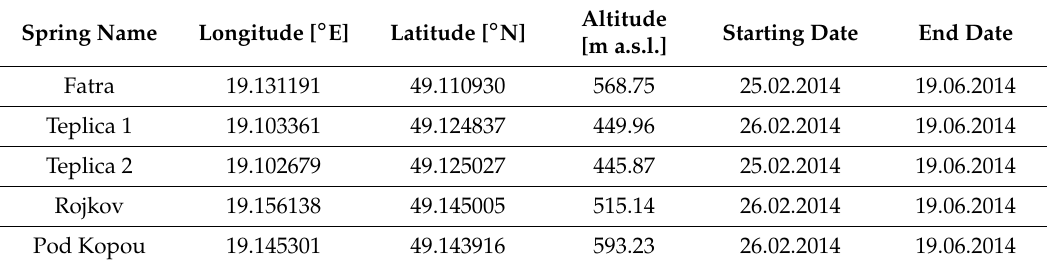
Table 1. Gauged karstic springs of the Kopa Mt. hydrogeological structure and period of discharge hourly gauging.